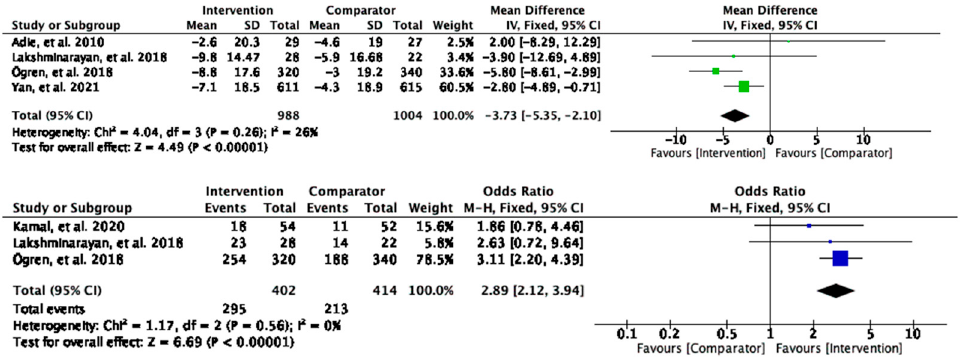
Figure 4. Meta-analysis results of intervention effect on systolic blood pressure.